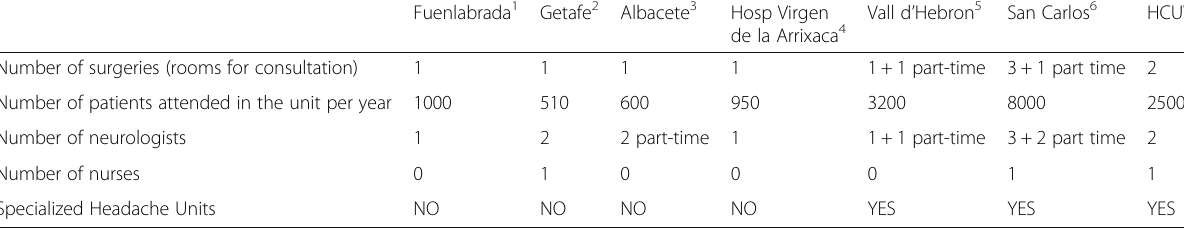
Table 1 Characteristics of the Specialized Headache Units taking part in this study